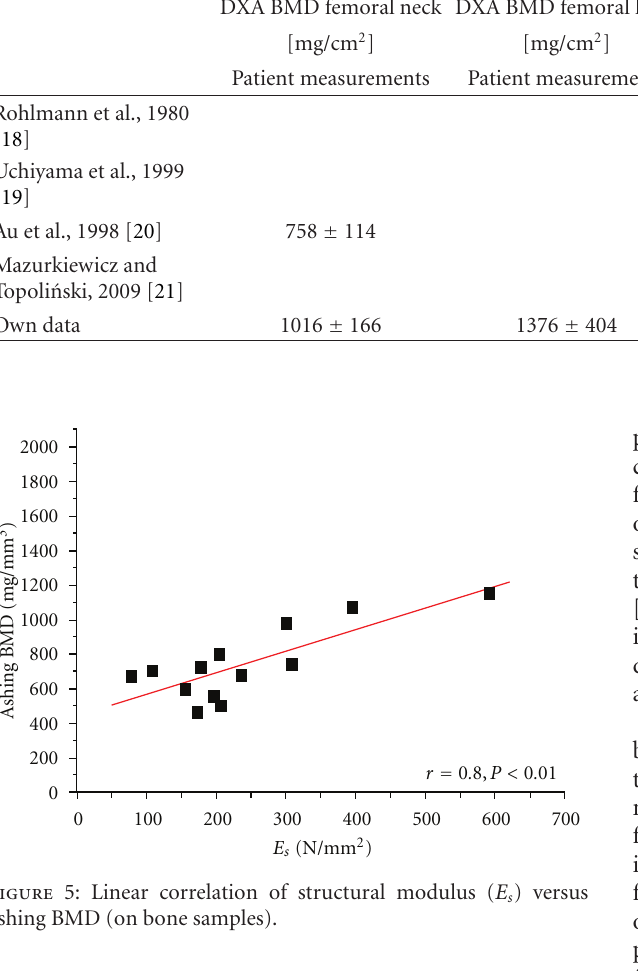
Bone samples Bone samples